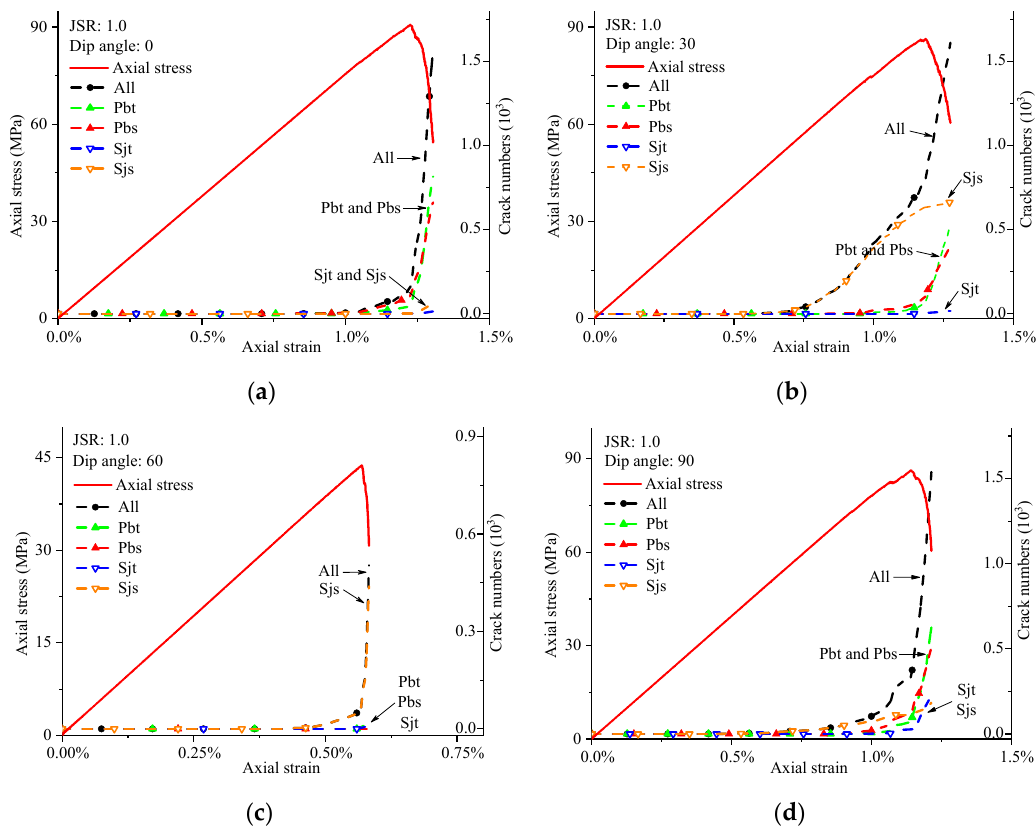
Figure 7. Stress-strain curves and evolution of micro-cracks simulated at different dip angles under uniaxial compression (joint strength ration (JSR) is 1.0; Sjs denotes shear crack of beddings; Sjt denotes tensile crack of beddings; Pbs denotes shear crack of matrix; Pbt denotes tensile crack of matrix). ( a ) dip angle = 0 ◦ ; ( b ) dip angle = 30 ◦ ; ( c ) dip angle = 60 ◦ ; ( d ) dip angle = 90 ◦